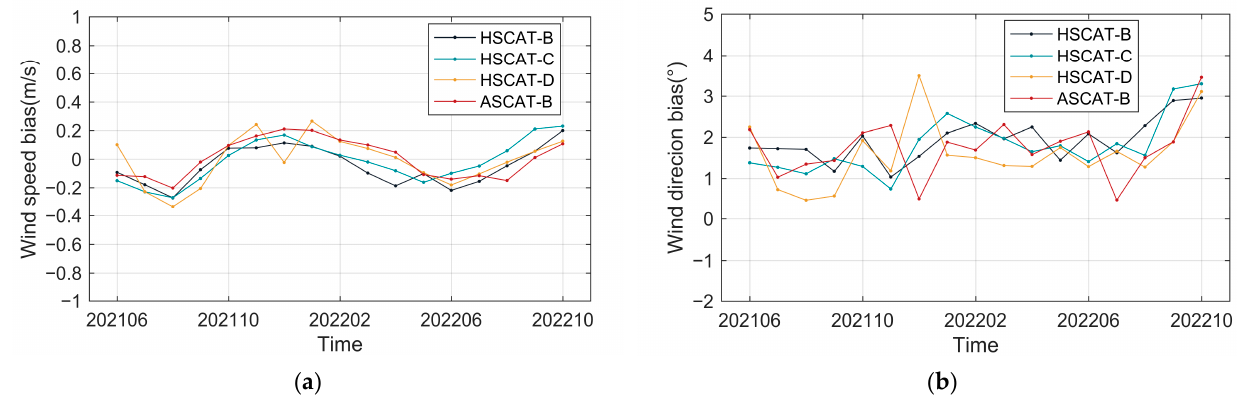
Figure 3. ( a , b ) The bias of scatterometer winds versus buoys from June 2021 to October 2022. Figure 3. The bias of scatterometer wind speed ( a ) and direction ( b ) versus buoys from June 2021 to October 2022. Table 3. Statistics of comparisons between scatterometer wind and ECMWF